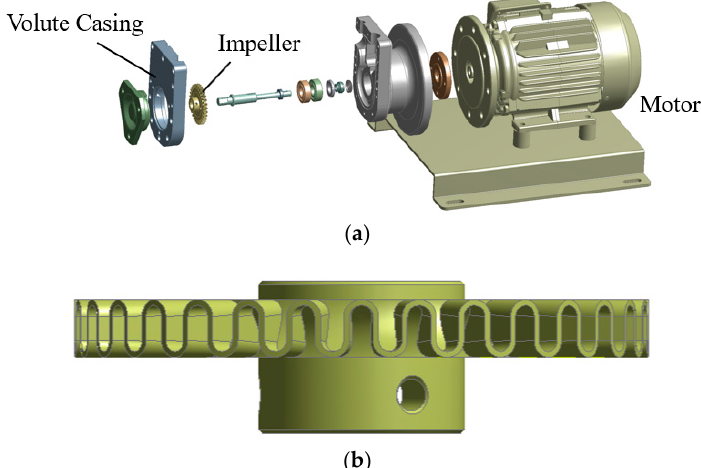
Figure 3. Basic configuration of a novel ‘S-shape’ pump impeller: ( a ) perspective view of a pump system, ( b ) newly designed impeller.